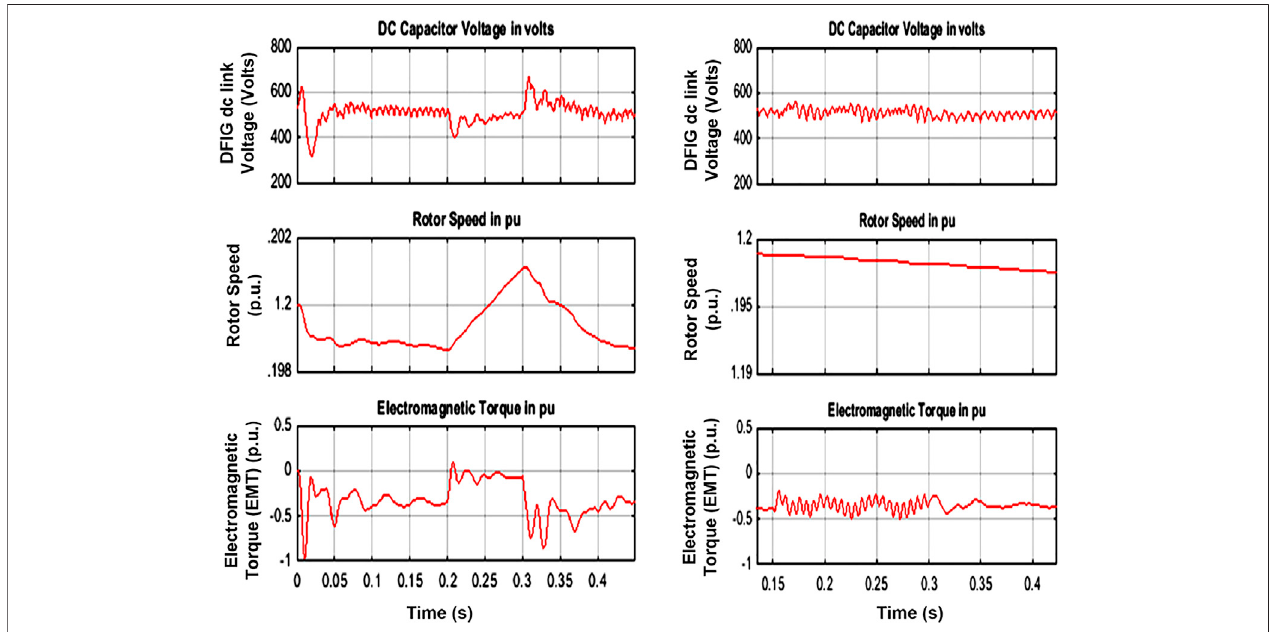
FIGURE 13 | . DFIG back-to-back converter dc-link voltage, rotor speed, and EMT with (i) control scheme (Moawwad et al., 2016) and (ii) proposed technique.